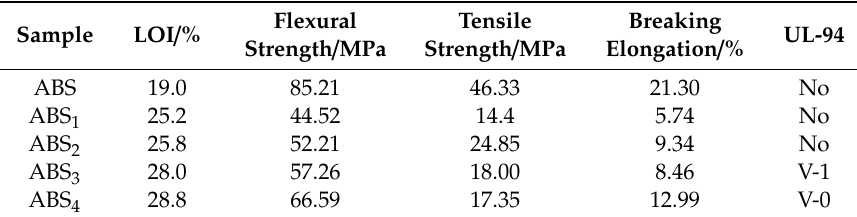
Table 3. Flame retardance and mechanical properties of the ABS composites with added Flame retardance and mechanical properties of the ABS composites with added O-CaMgAl-LDHs, APP, and EG. O-CaMgAl-LDHs, APP, and EG.